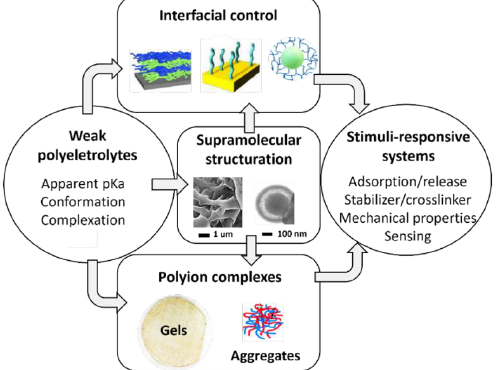
Figure 1. Weak polyelectrolyte as a multipotent tool for stimuli-responsive systems. Depiction of the different usages of weak polyelectrolytes for supporting the nanoarchitectonic design of func- tional materials addressing stimuli-responsive applications.